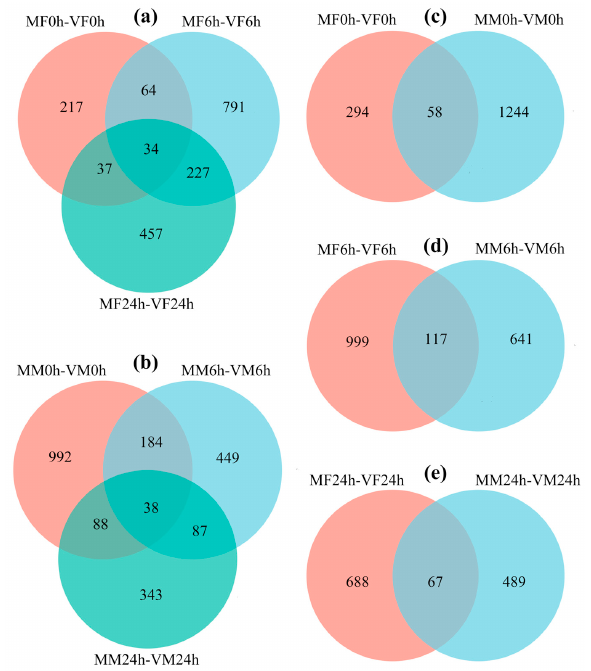
Figure 4. Venn diagrams of DEGs in S. frugiperda . ( a , b ) are common DEGs in females and males at 0, 6 and 24 h postmating, respectively; ( c – e ) are common DEGs shared by both sexes at 0, 6 and 24 h postmating, respectively. The overlapping circles represent common DEGs among all combina-tions.